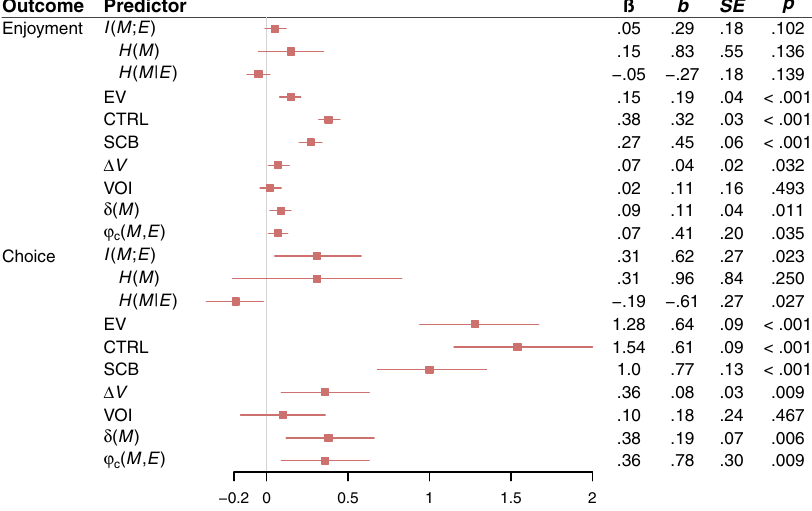
Fig. 4 Enjoyment results from experiment 2. Effects of all variables of interest on the continuous measure of enjoyment and the binary choice measure of which game participants would rather play again in experiment 2. The variables of interest are I(M;E) , its constituent entropy terms H M ð Þ and H M j E ð Þ , expected value (EV), controllability (CTRL), skill-challenge balance (SCB), marginal value ( Δ V ), the value of information (VOI), temporal difference prediction error ( δ M ð Þ ), and the correlation between M and E ( φ ð M ; E Þ ). Effects on choice are coded such that positive scores correspond to a tendency to c choose the game with the highest value of the relevant variable. Statistics are derived from LMMs (two-sided) performed over 488 observations across 249 participants. Each LMM regresses one variable from the outcome column on one variable from the predictor column (with the exception of H M ð Þ and H M j E ð Þ , which are included in the same model), a nuisance regressor for game order ( fi rst game vs. second game), and random subject-level intercepts. Red squares denote standardized regression coef fi cients, and intersecting red lines represent 95% CIs. No corrections for multiple comparisons were